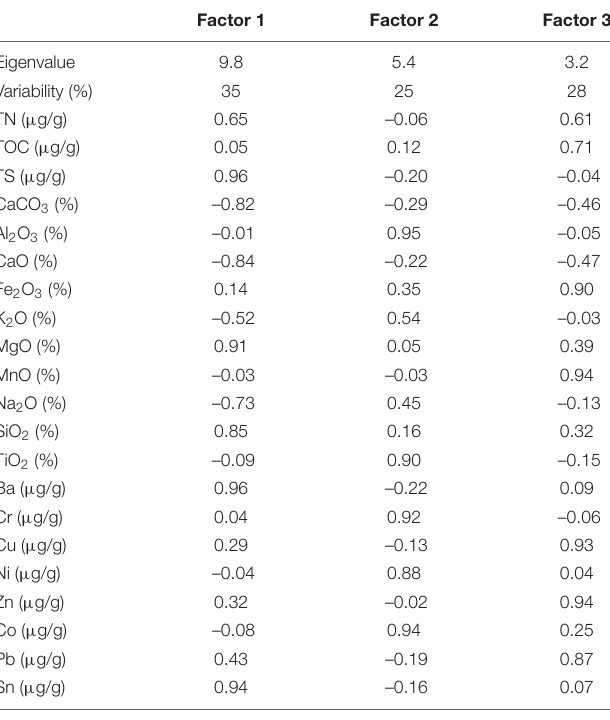
TABLE 3 | Results of principal component analysis for the sediment dataset and percentage of variance explained for the individual factor loadings ( > 0.5 value). Factor 1 Factor 2 Factor